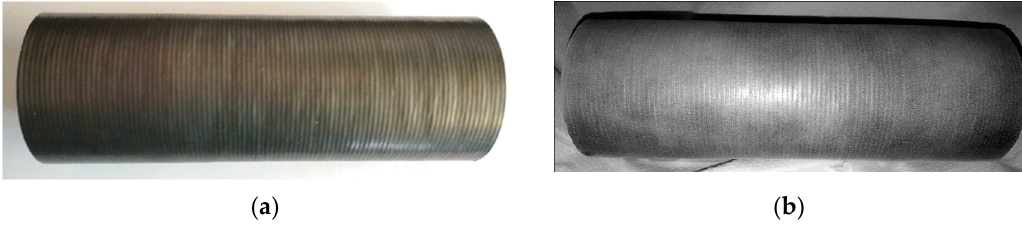
Figure 3. Photograph of Inconel 625 nickel ‐ based superalloy surfaced layer on 16Mo3 steel pipe: ( a ) after surfacing, ( b ) after dye ‐ penetrant application, removal and developer application (visible pipe length L = 180 mm, diameter D = 51 mm and thickness t = 5 mm).